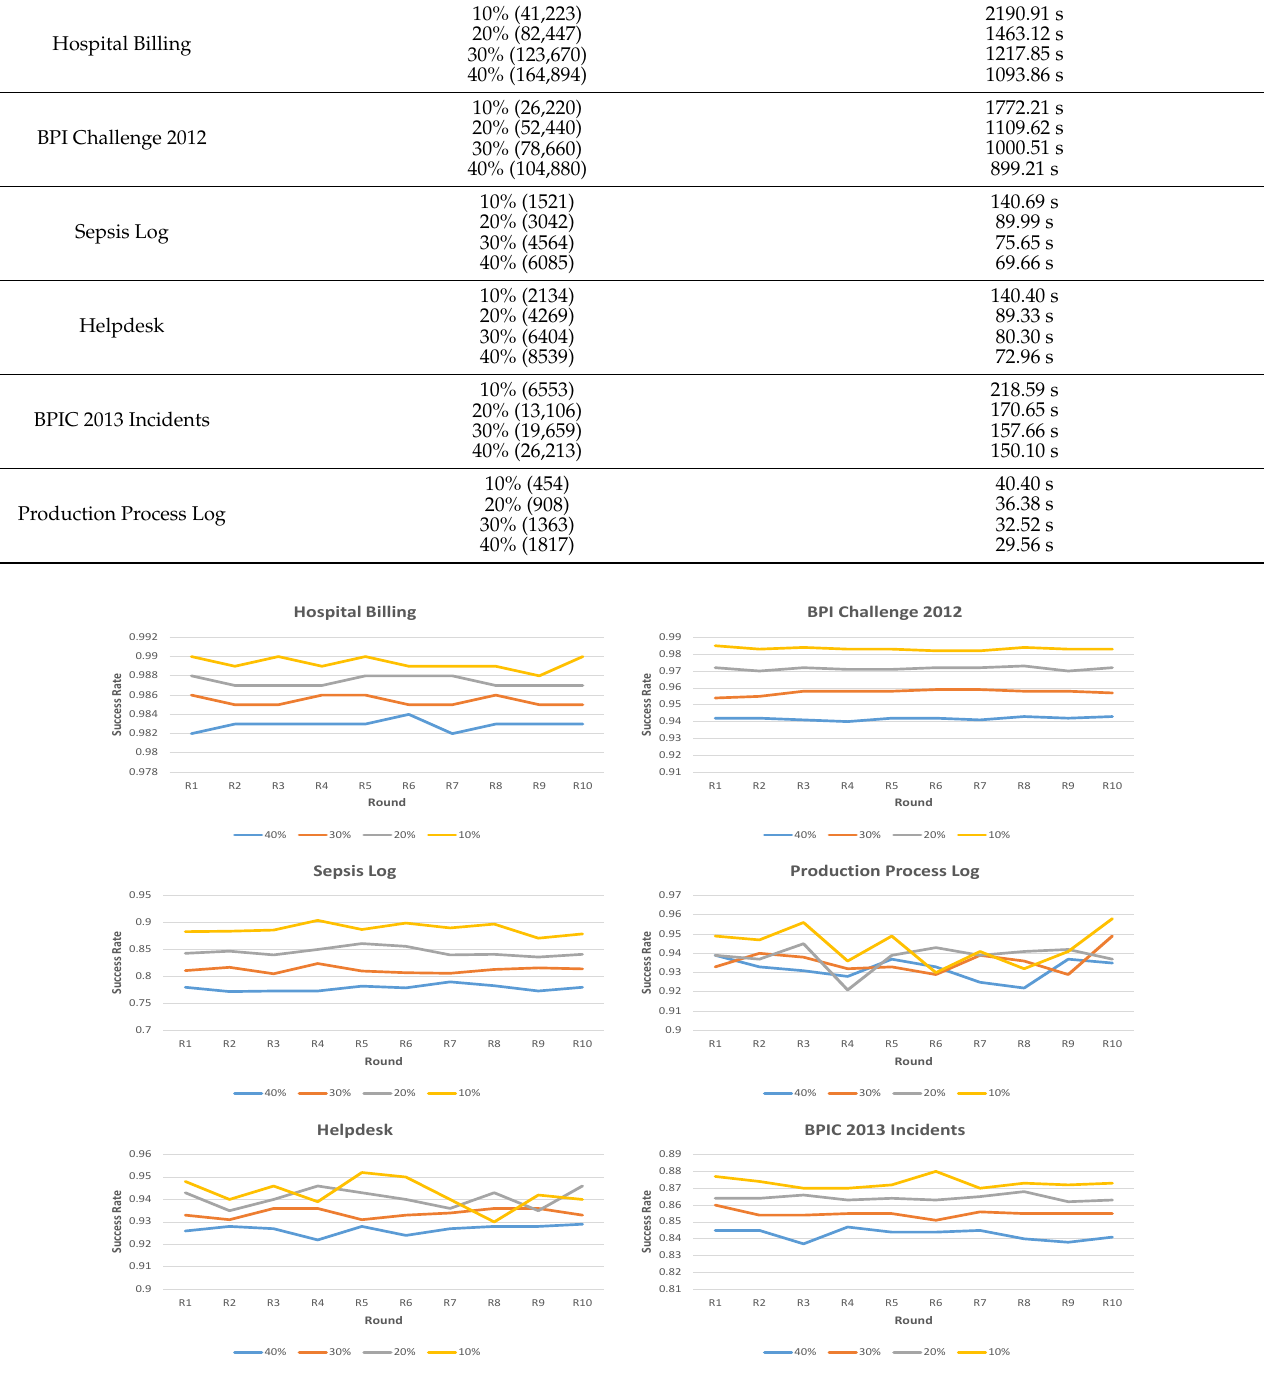
Figure 8. Successful rates of our method on different datasets in different